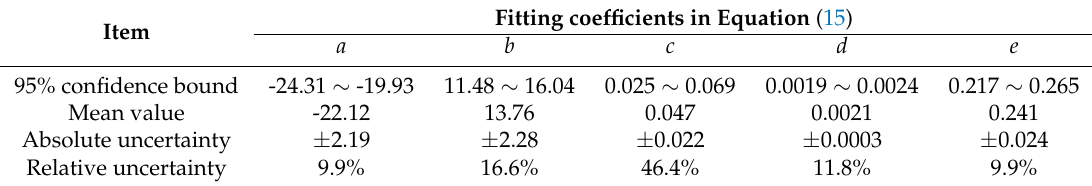
Table 3. Results of fitting